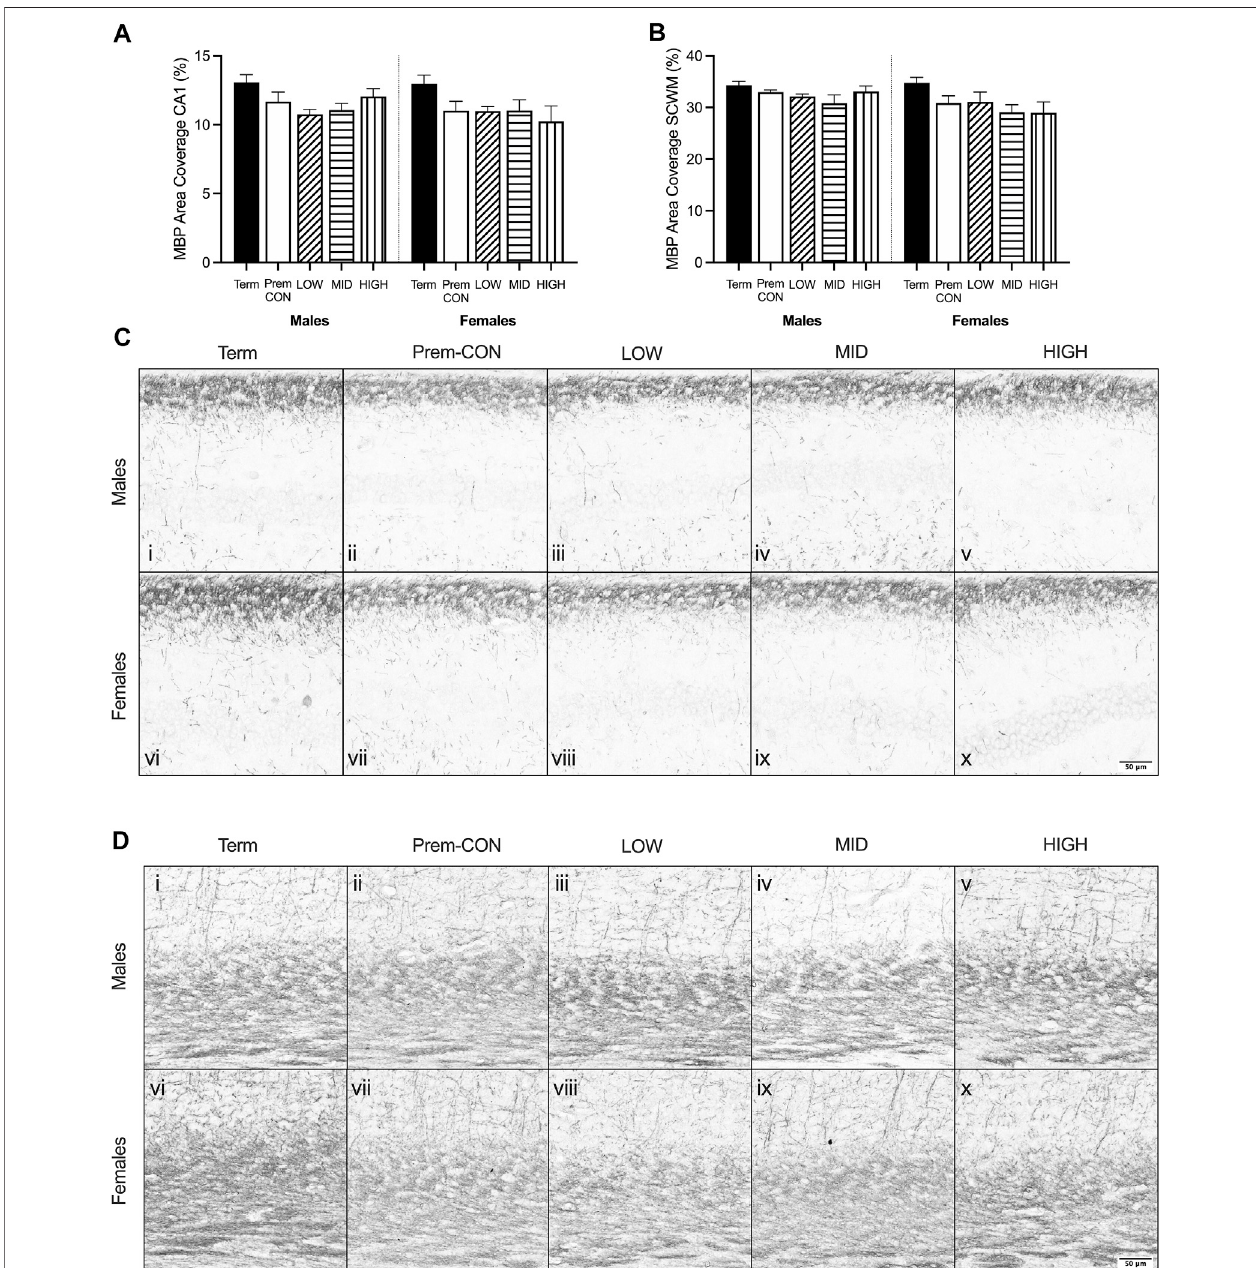
FIGURE2| Myelinbasicprotein (MBP)immunostaining wasquanti fi edinthebrainoftermcontrol(black;males n =8,females n =7),pretermcontrol(white; males n = 7, females n = 7), low-GNX (diagonal stripes; males n = 6, females n = 5), mid-GNX (horizontal stripes; males n = 6, females n = 6), and high-GNX (vertical stripes; males n = 6, females n = 5) for (A) the CA1 region of the hippocampus and (B) the overlying subcortical white matter. Data presented as means ± SEM with * indicating signi fi canceat p < 0.05. (C) RepresentativephotomicrographsofMBPimmunostainingofthe (C) CA1regionand (D) overlyingsubcorticalwhitematter(i,vi=term; ii, vii = preterm control; iii, viii = low-GNX preterm; iv, ix = mid-GNX preterm; v, x = high-GNX preterm). Scale bar = 50 μ m.